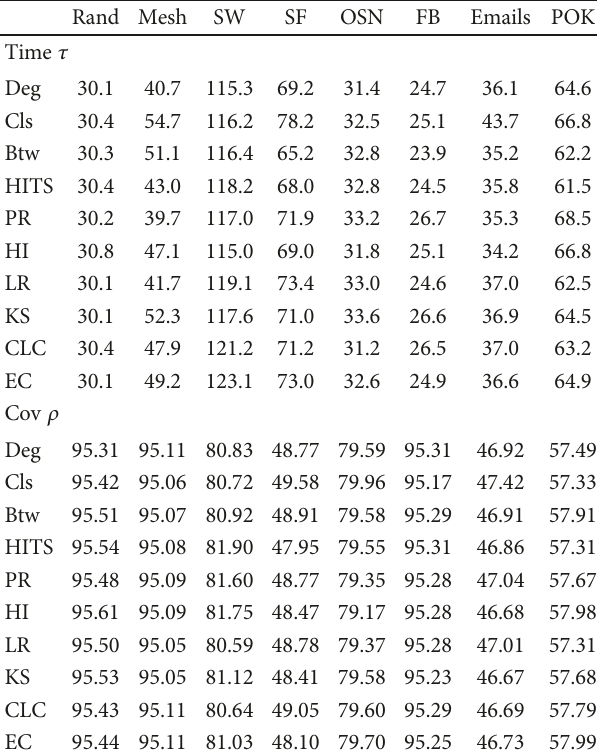
Table 2: Performance of ranking methods expressed as the time τ needed to infest a network (lower is better) and the fi nal coverage ρ , expressed as a percentage of the network size (higher is better), using SIR benchmarking. Rand